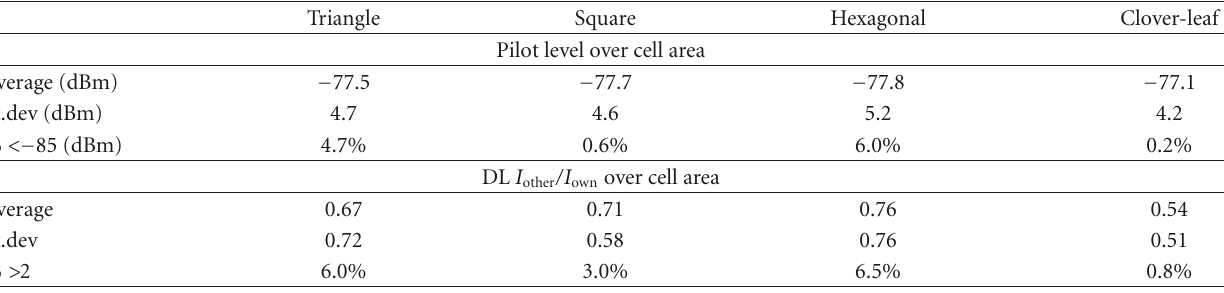
Table 6: Results of the theoretical analysis for signal statistics over network area. Triangle Square